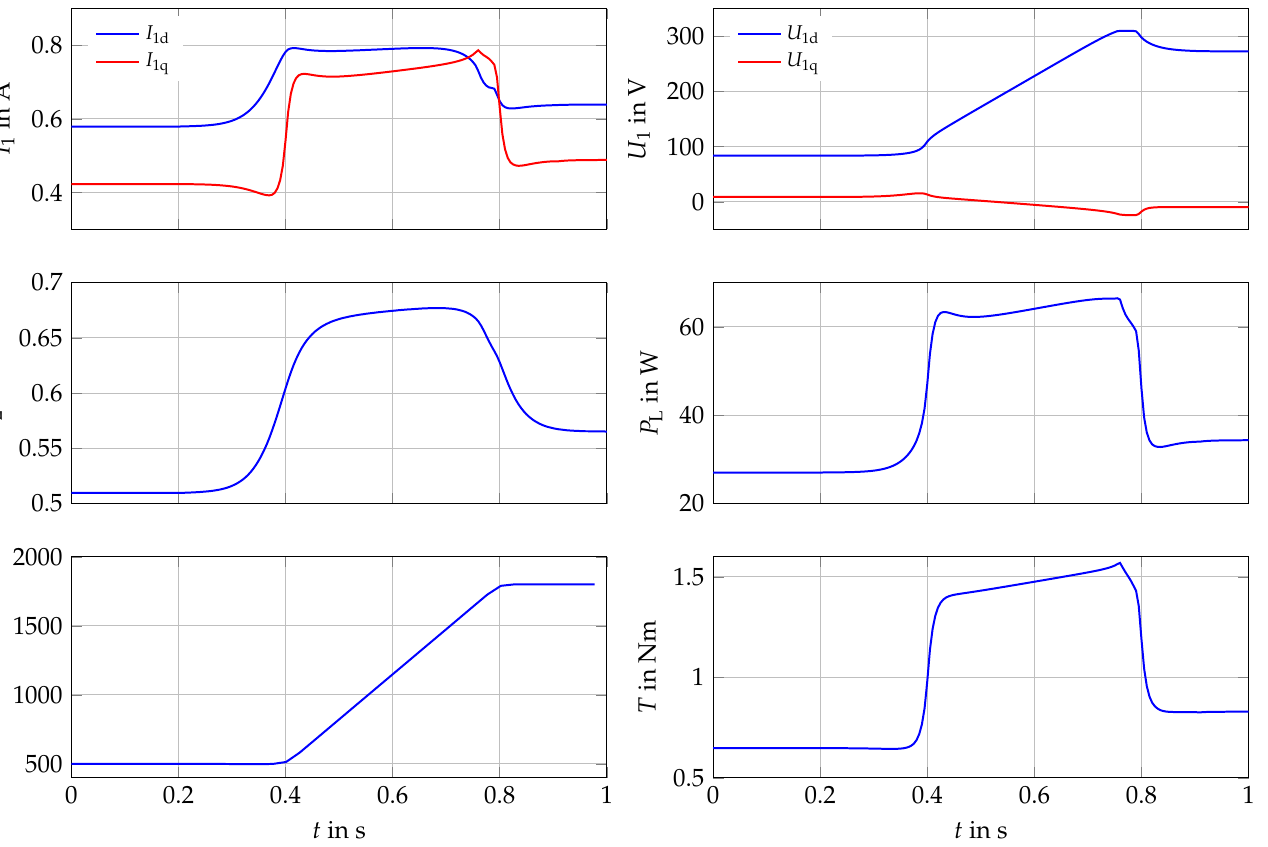
Figure 3. Offline optimization